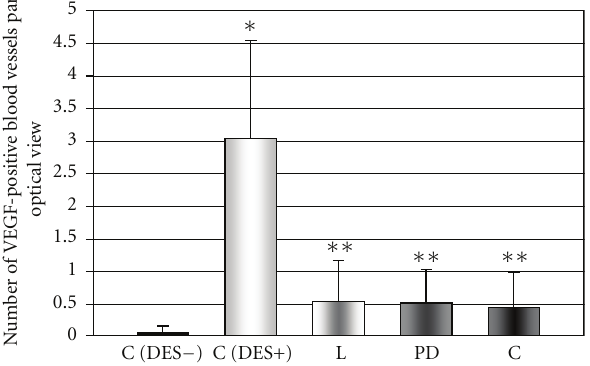
Figure 3: The influence of AT1 receptor antagonist losartan (L), AT2 receptor antagonist PD123319 (PD) and ACE inhibitor capto- pril (C) on diethylstilboestrol- (DES-) induced increase in number of vascular endothelial growth factor (VEGF) immunopositive cells in anterior pituitary of rats. X ± SEM; ∗ P < 0 . 05 versus C (DES − , control DES-untreated group), ∗∗ P < 0 . 05 versus C (DES+, control DES-treated group). pale gray : weak VEGF immunoreactivity; dark gray : medium VEGF immunoreactivity; black : strong VEGF immunoreactivity.